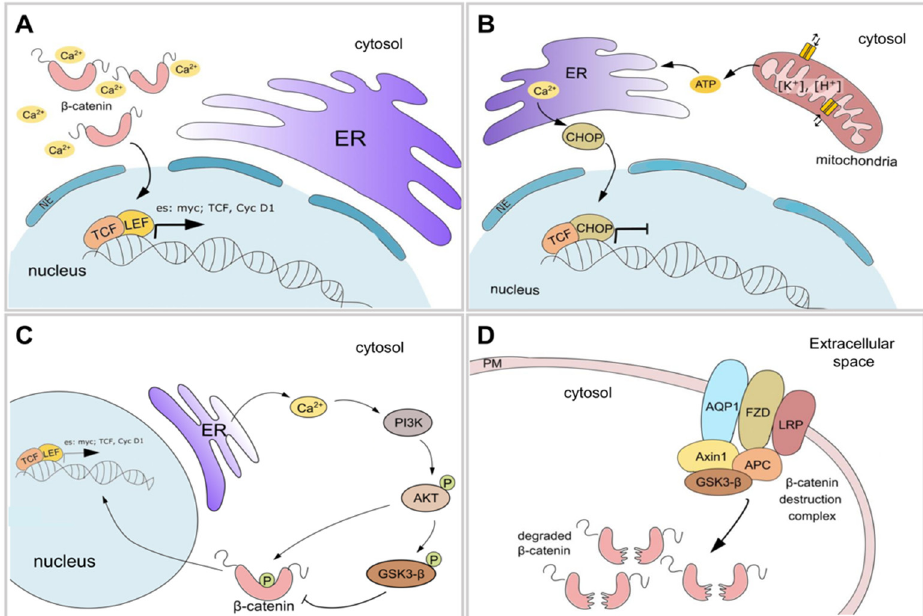
Figure 2. Ca 2+ dynamics finely tune canonical Wnt signaling. ( A ) β -catenin is a negatively charged protein, which cannot passively overcome nuclear membranes. Ca 2+ release from the ER contributes to the neutralization of the negatively charged residues of β -catenin, enabling its translocation into the nucleus. ( B ) Mitochondrial homeostasis are requirements for all the cell, including glycolytic ones. Indeed, the mitochondrial ATP synthesis enables Ca 2+ storage in the ER. When the ion balance (e.g., [H + ], [K + ] and/or [Ca 2+ ]) is improper, the ER-stress arise. The ER-stress cascade activates CHOP, which represses Wnt signaling by competing with TCF, ultimately resulting in negative regulation of the Wnt cascade. ( C ) Wnt signaling is closely interconnected with other pathways, such as the PI3K/AKT pathway, which plays a crucial role in Wnt signaling regulation by modulating GSK3 β activity. In this context, Ca 2+ concentration plays a critical role in the Wnt/AKT crosstalk. ( D ) Channel proteins can also contribute to Wnt regulation in a pore-independent manner, such as Aquaporin1 (AQP1). Recent evidence demonstrated that AQP1 physically interacts with GSK3 β , Axin1, and LRP in a multi-complex platform that eventually promotes complex activity